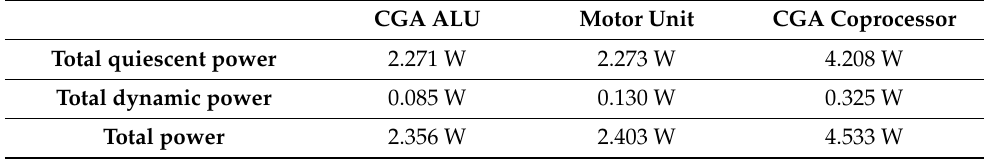
Table 6. Power consumption on the Xilinx Virtex-5 XC5VFX130T FPGA